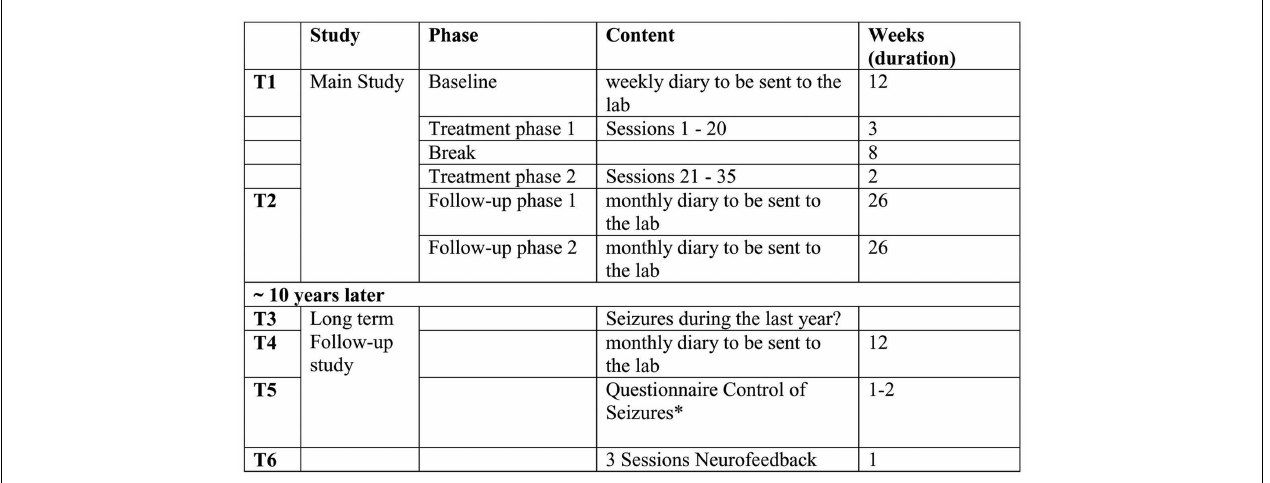
FIGURE 1 |Timeline of assessments of seizure frequency, treatment, and follow-up evaluations . *Fragebogen zur Kontrolle von Anfällen (COE, control of epileptic seizures questionnaire) byTrevorrowT and Strehl U,